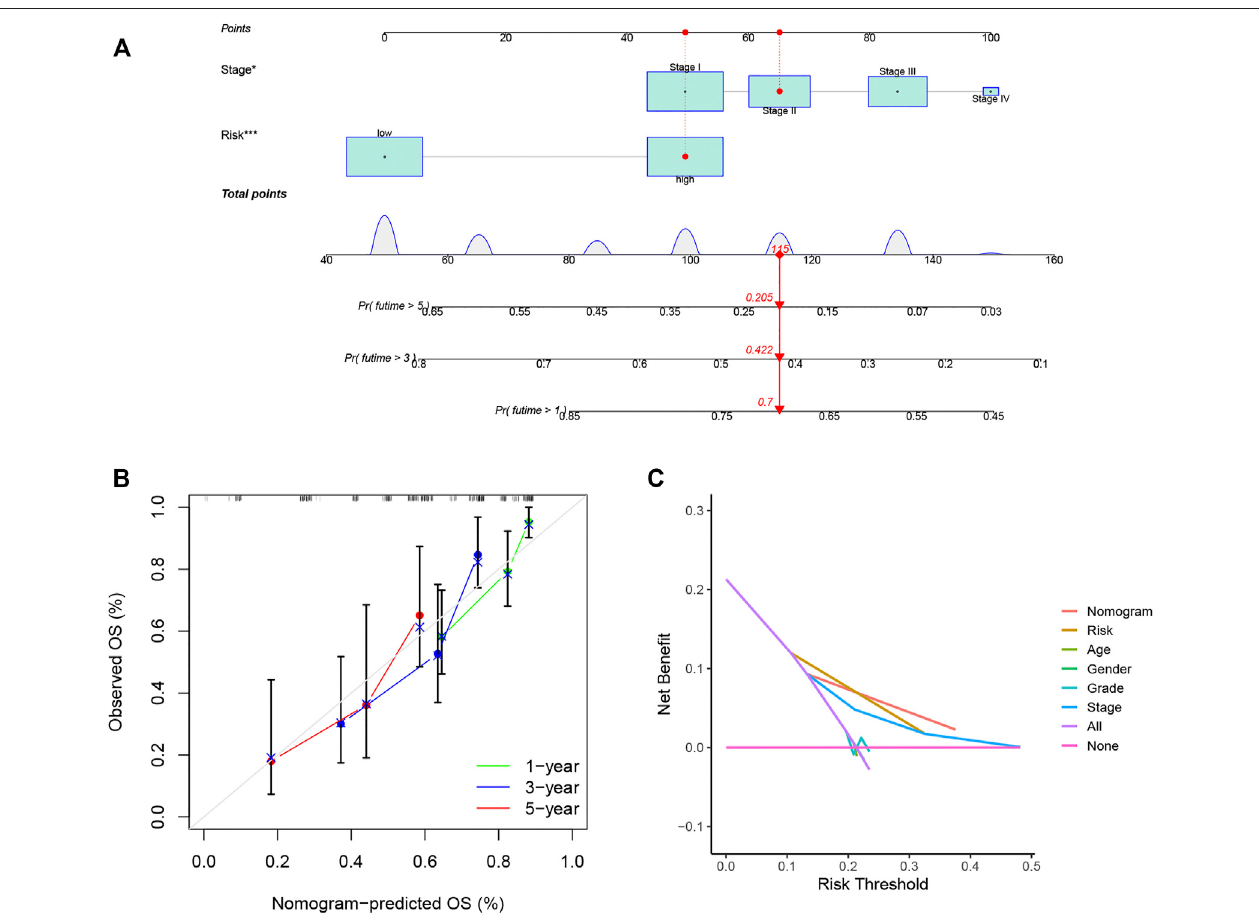
FIGURE 7 | Nomograms for LIHC OS prediction. (A) Nomograms combining the OS signature and three clinical variables of LIHC patients in the training set. (B) Calibration curve for assessment of the reliability of OS prediction by the nomogram. (C) DCA curve showing the clinical utility of the signature. * p < 0.05, *** p < 0.001.